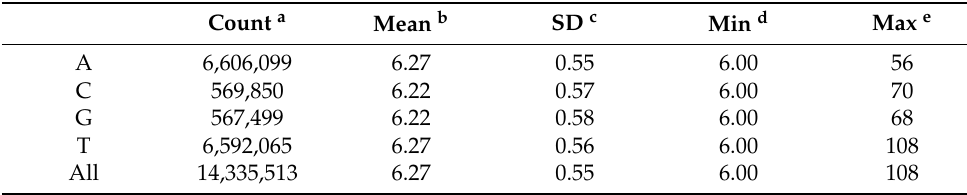
Table 1. Repeat length of the observed homopolymeric